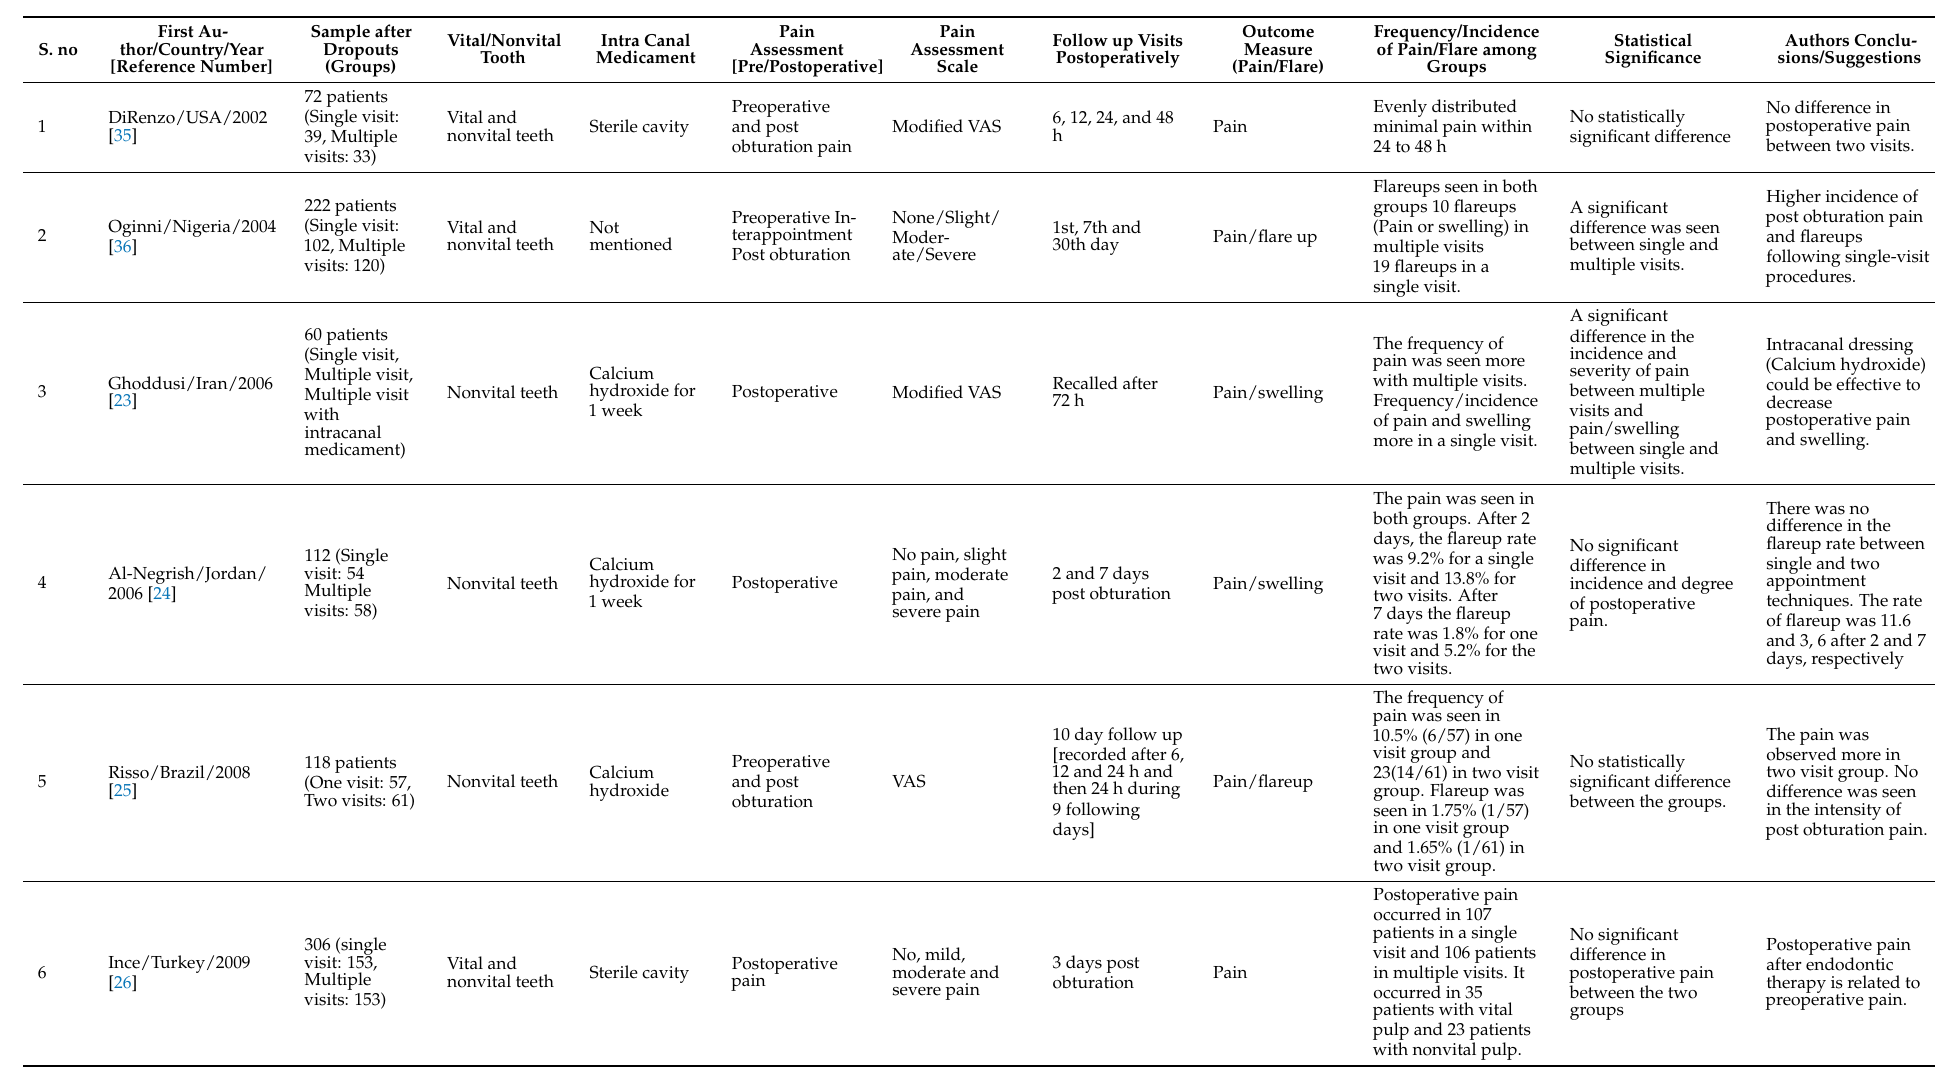
Table 1. Summary of the data extracted from the studies included in the systematic